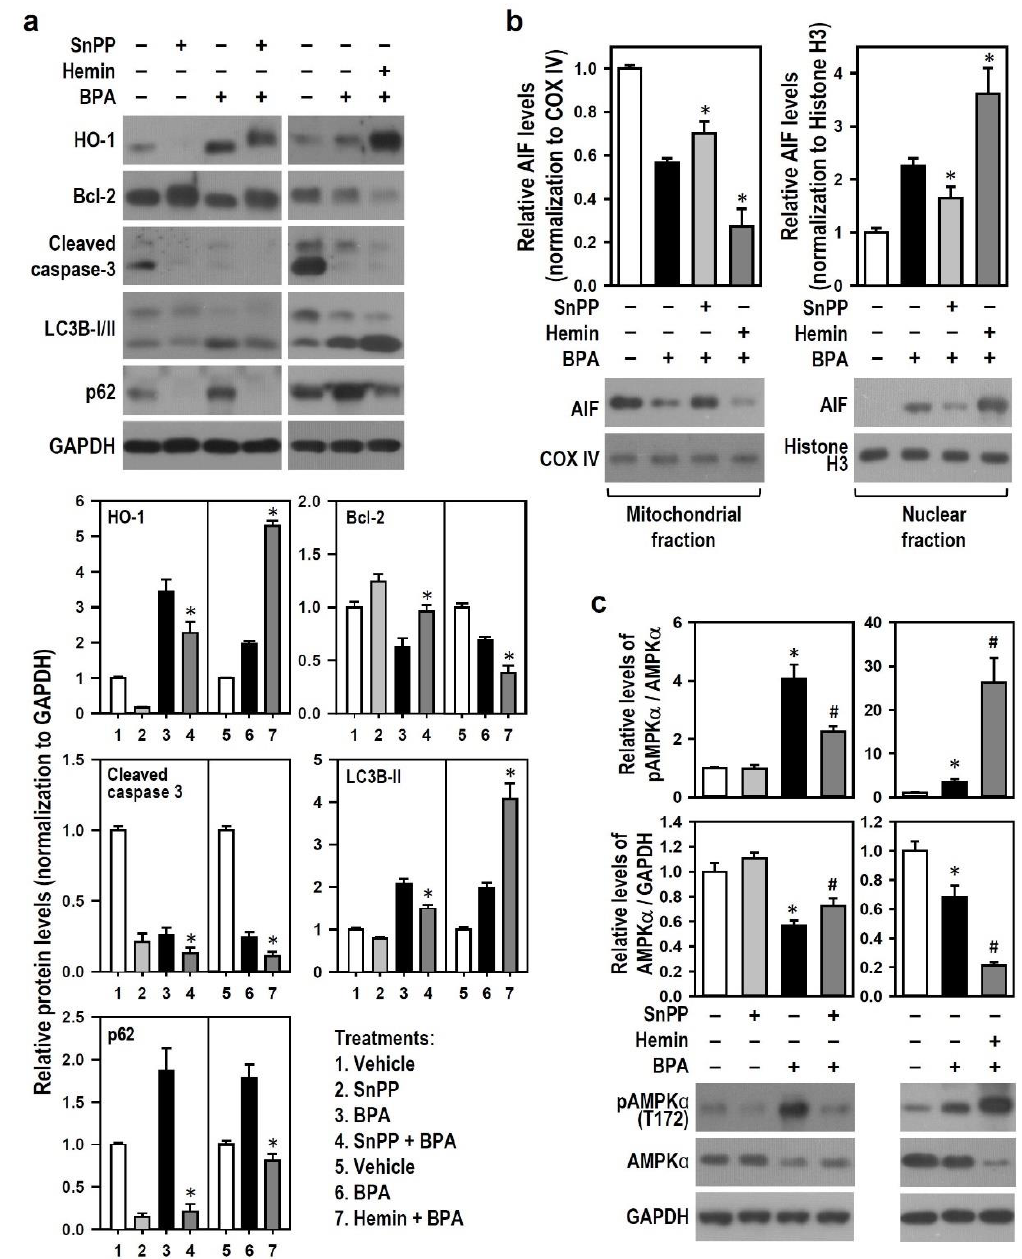
Figure 6. HO-1 mediates BPA effects on autophagy activation, nuclear translocation of AIF, and AMP-activated protein kinase (AMPK) α phosphorylation, as well as the down-regulation of cleaved caspase-3, Bcl-2, and AMPK α . ( a ) Cultures were exposed to 30 µ M SnPP or 10 µ M hemin for 30 min before being treated with or without 100 µ M BPA for 24 h. HO-1, Bcl-2, cleaved caspase-3, LC3B, and p62 levels were detected by Western blots. The bar plots show the relative quantitation data of these proteins. Values are represented as mean ± SEM ( n = 4). * p < 0.05 vs. BPA alone. ( b ) Cultures were pretreated with 30 µ M SnPP or 10 µ M hemin for 30 min and continuously incubated with 100 µ M BPA for 12 h. Cultures were subjected to subcellular fractionation after harvest. AIF level was detected by Western blots. COX IV and histone H3 were markers standing separately for mitochondrial and nuclear fractions. The bar plots show the quantitative results relative to the untreated control group (assigned a value of 1). Data are represented as mean ± SEM ( n = 4). * p < 0.05 vs. BPA alone. ( c ) Similar manipulation was conducted as ( a ), and pAMPK α and AMPK α levels were detected by Western blots. The bar plots show the quantitative values of pAMPK α (normalized by AMPK α ) and AMPK α (normalized by GAPDH) relative to the untreated control group (assigned a value of 1). Data are represented as mean ± SEM ( n = 4). * p < 0.05 vs. control group; # p < 0.05 vs. BPA